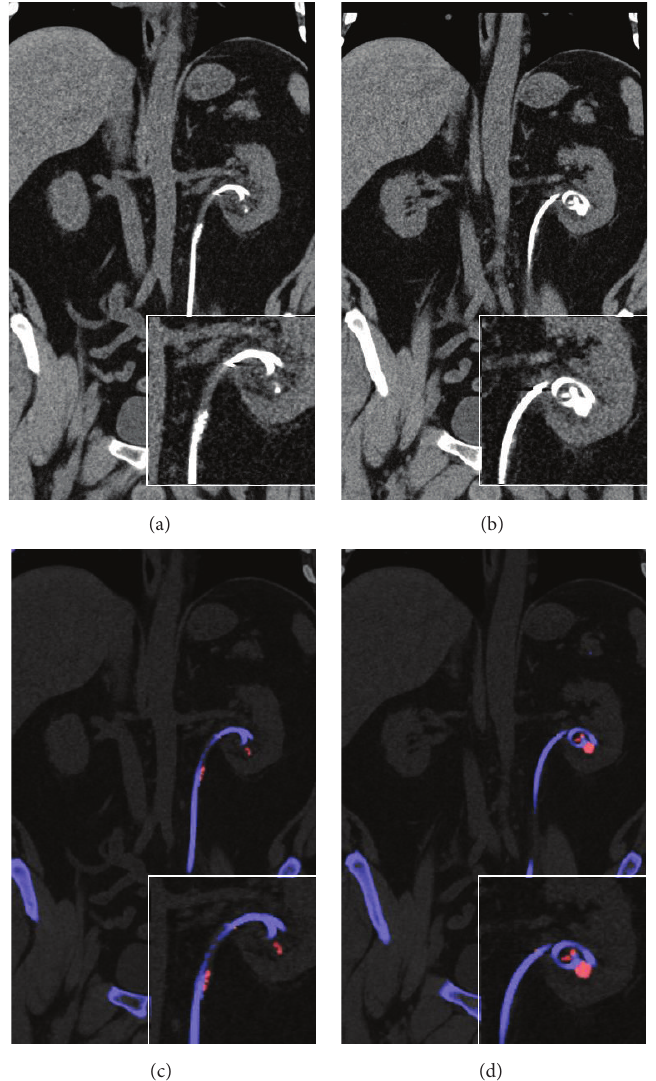
Figure 1: Two-dimensional coronal conventional computed tomography (CT) ((a), (b)) and dual-energy computed tomography (DECT) ((c), (d)) images showing kidney stones (magnified insets) and nephrostomy stent. The stones and stent have the same contrast in conventional CT, while, in DECT, the stones and stent appear red and blue,